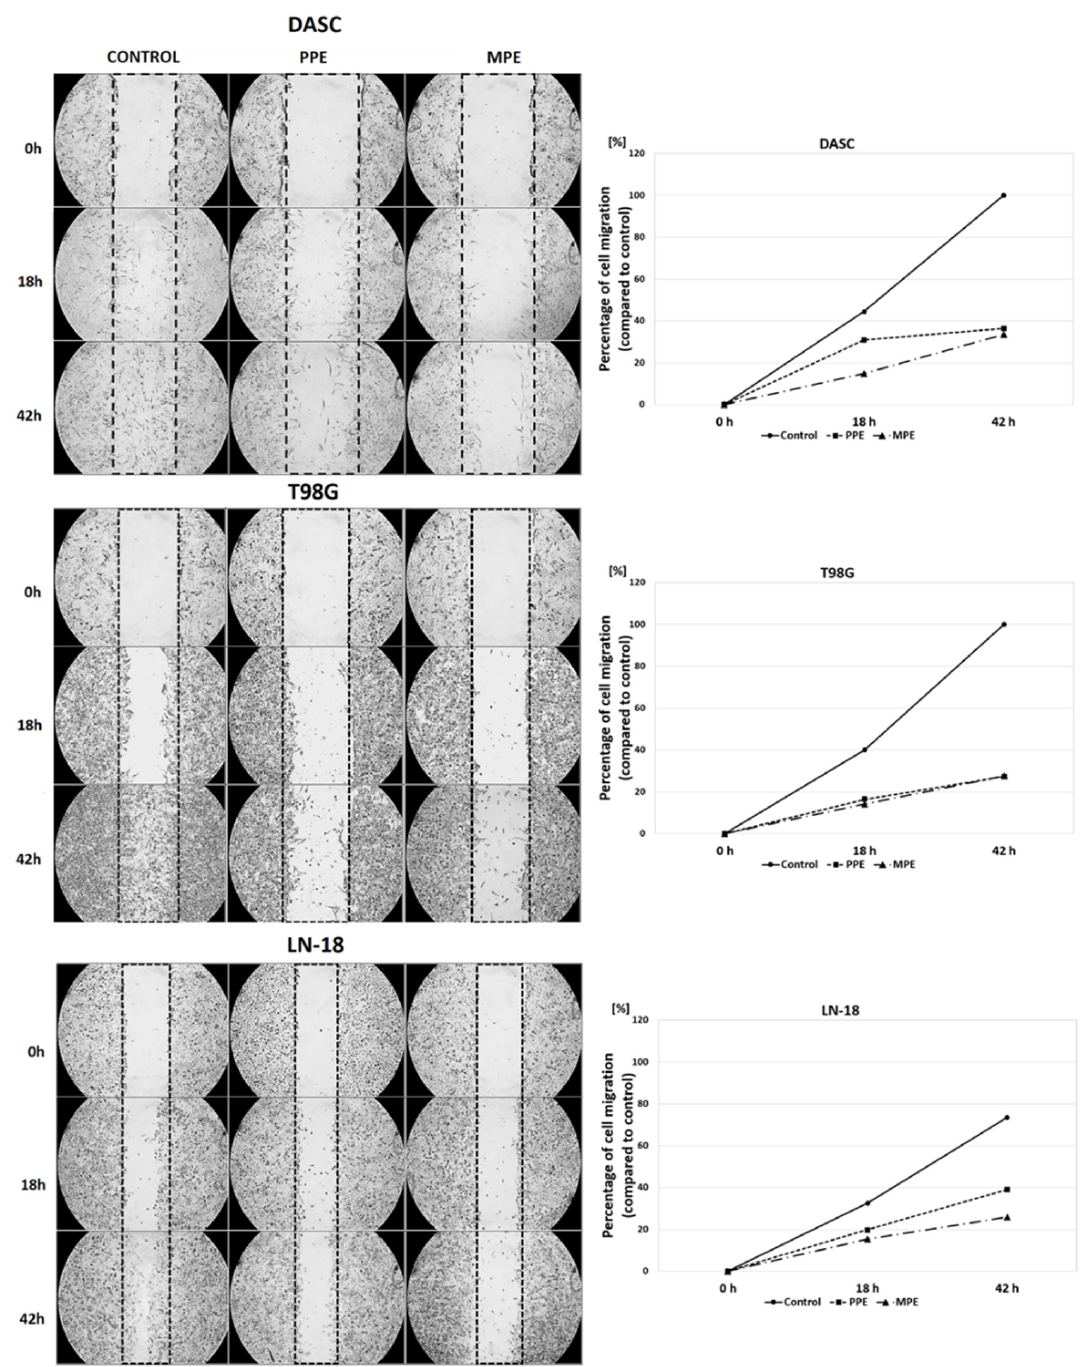
Figure 3. The effects of EEP (6.25 µ g/mL) and MPE (30 µ g/mL) on DASC, T98G and LN-18 on cells migration after 0, 18, 42 h of incubation.